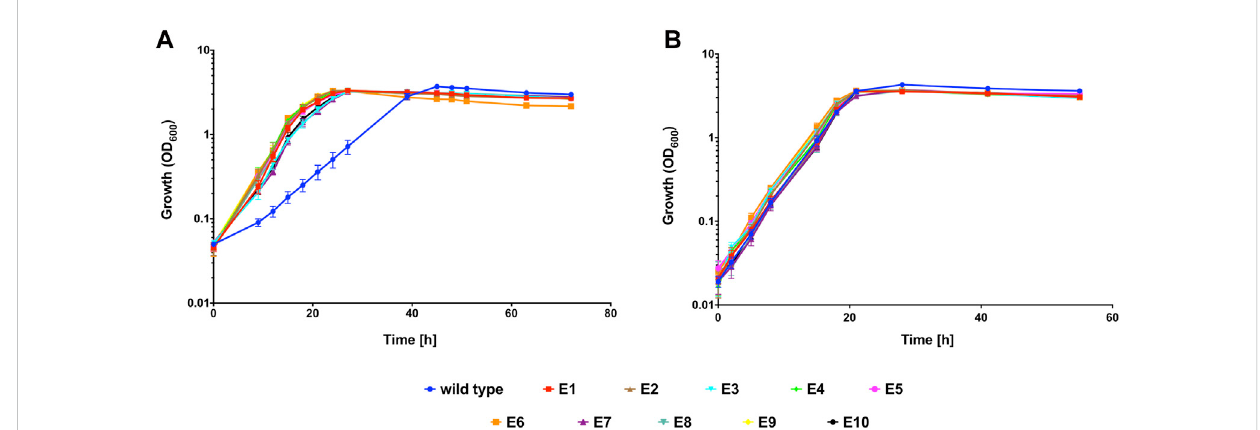
FIGURE 2 Heterotrophicgrowth ofevolved C.necator isolates E1toE10 compared towildtype C.necator H16inthepresenceofCO.Culturesweregrown at 30 ° C in 20 mL F-MM contained in 150 mL serum bottles under a 2 bar atm of (A) 50% CO/50% air (v/v) or (B) 50% N 2 /50% air (v/v). Blue circles, wild type; red squares, E1; brown triangles, E2; cyan inverted triangles, E3; green diamonds, E4; pink circles, E5; orange squares, E6; purple triangles, E7; turquoise inverted triangles, E8; yellow diamonds, E9; black circles, E10. Error bars represent the standard deviation of the mean for two independent replicates.